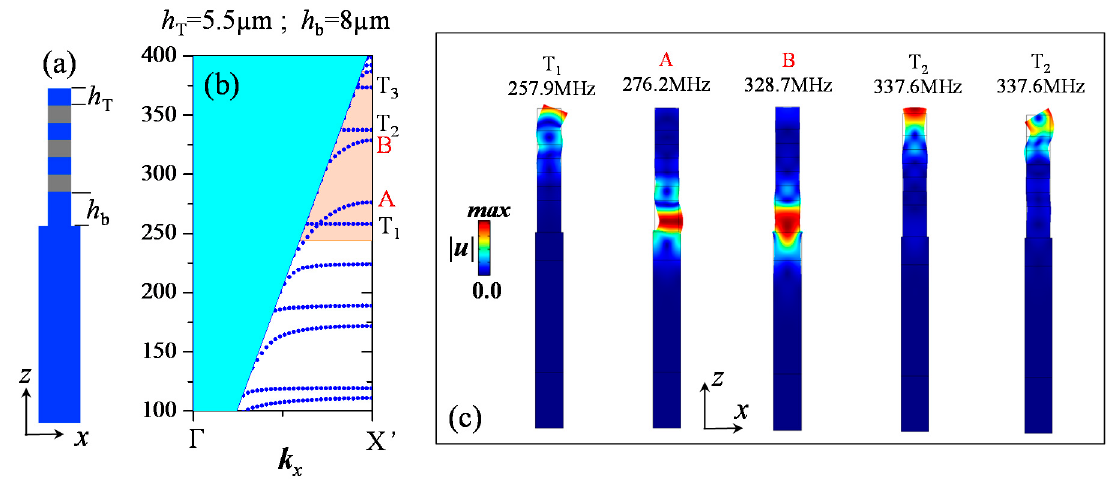
Figure 5. ( a ) Unit cell of the PC system where the thickness of the bottom Si layer h b is fixed to 8 µm while the top Si layer thickness is h T = 5.5 µm. ( b ) Band structures for PC system. ( c ) Total displacement field amplitude |u| for the confined modes inside the band gaps at X’ point.